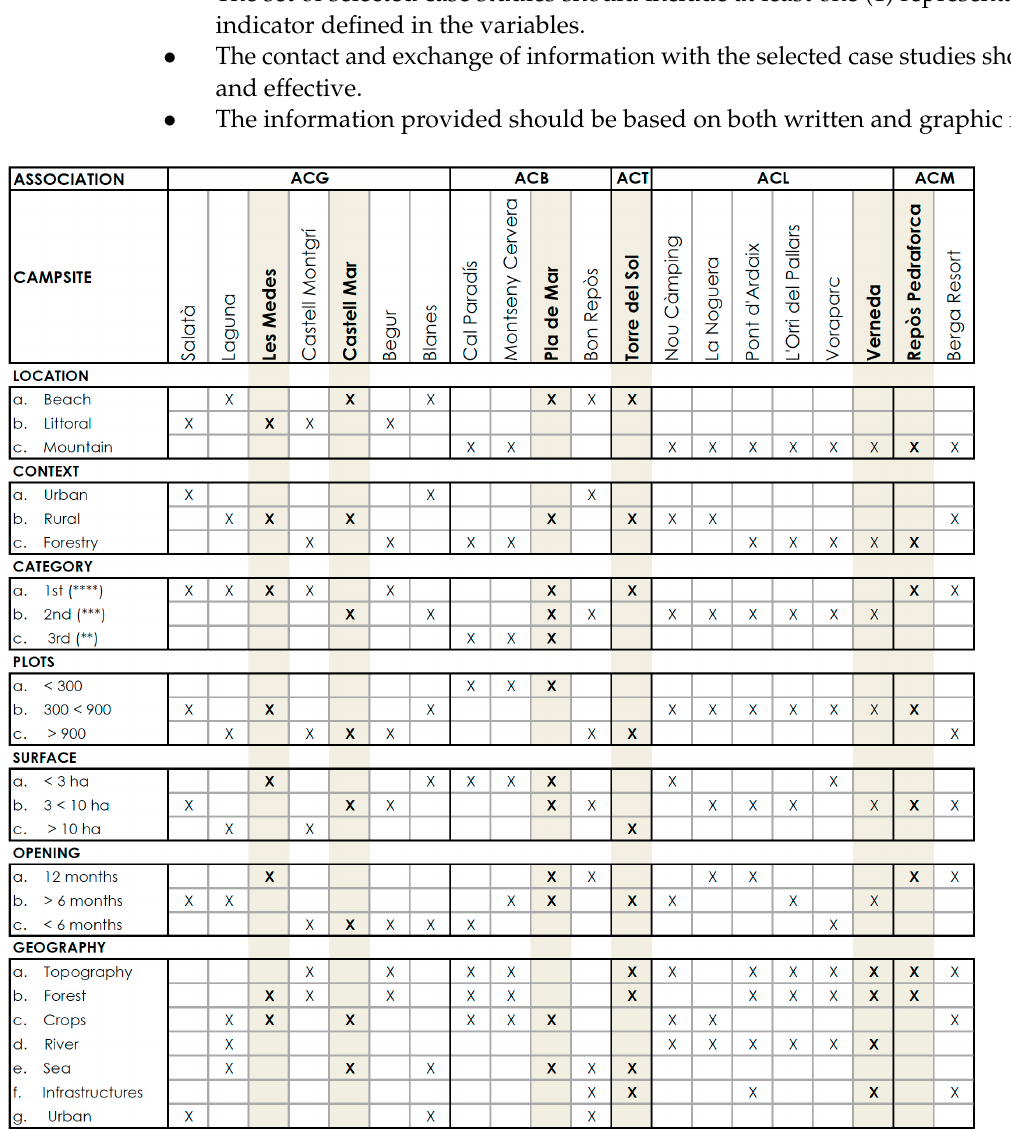
Figure 2. Identification and selection of eligible case studies, according to the variables considered in relation to the landscape, the settlement, and its activity. Selected case studies are highlighted and in bold type. Categories are identified by levels and stars: **, ***, **** (Source: authors’